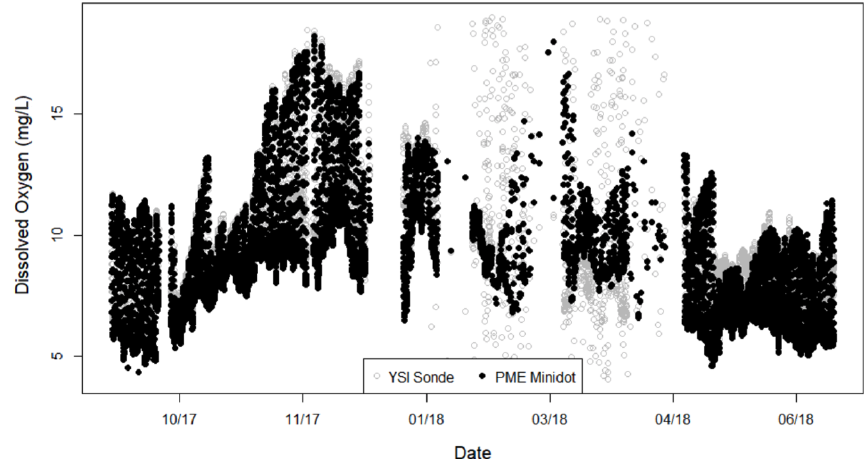
Figure A2. Dissolved oxygen measurements from the two sensors – YSI Sonde and PME miniDOT – at Bridge 1 on Stroubles Creek. The spread of YSI Sonde values spanning from the end of January to mid-April was likely a result of a freeze event. We used PME data during